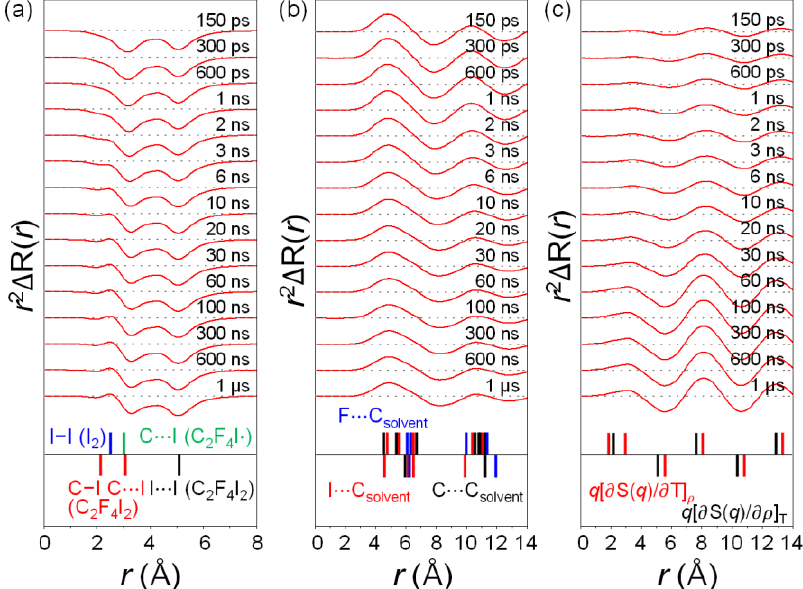
Figure 2. ∆ RDFs represented in r -space are decomposed into three components: ( a ) solute-only term, ( b ) solute–solvent cross term, ( c ) solvent-only term. Lines in ( a ) correspond to the bond lengths of solute species calculated by DFT calculation. Black, red, green, and blue lines correspond to I − I of C 2 F 4 I 2 , C − I of C 2 F 4 I 2 , C − I of C 2 F 4 I · radical, and I − I of I 2 , respectively.